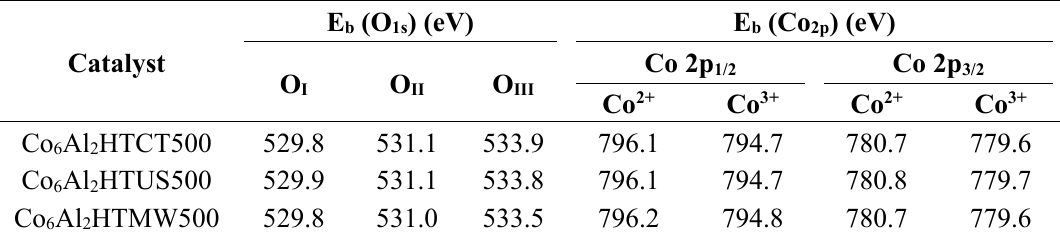
Table 3. Binding energy (E b ) for O 1s and Co 2p levels for the catalysts.